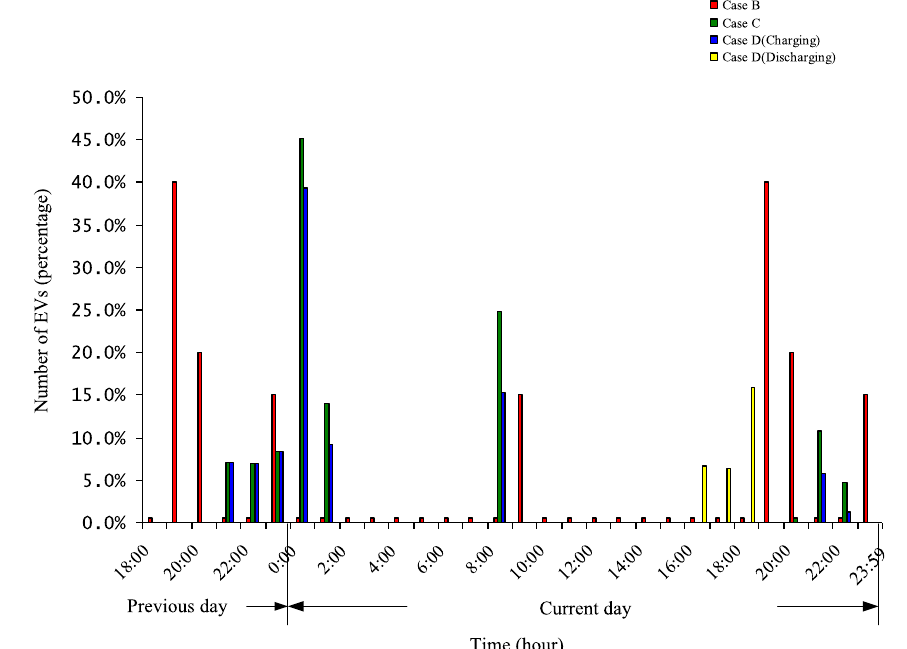
Fig. 7 Hourly charging/discharging schedules under four